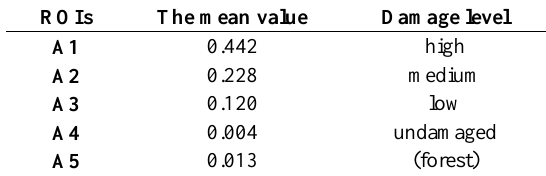
Table 3. The mean values of the D index of the ROI A1 to